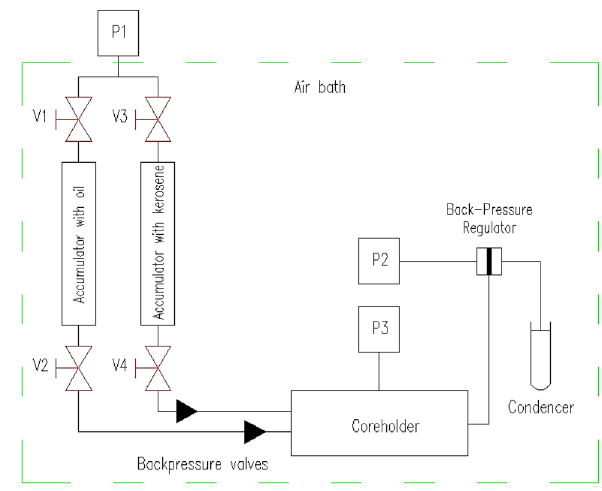
Fig. 2 Schematic diagram of the filtration equipment. (P)—pump,